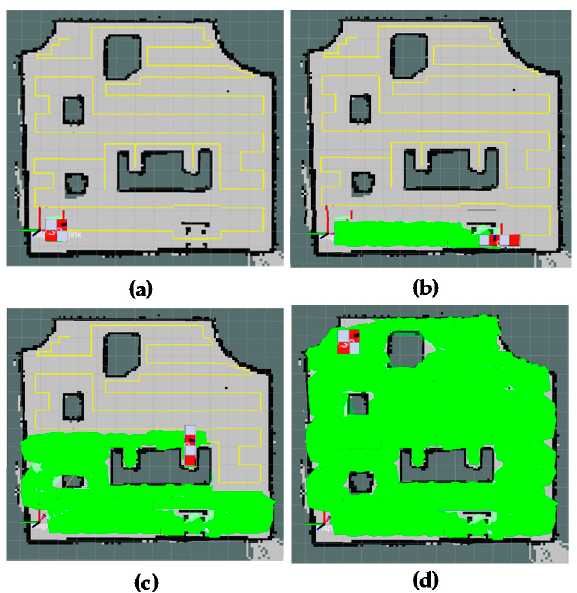
Figure 17. Areas coverage by the proposed method. ( a ) global path planning, ( b ) reconfiguration form O shape to horizontal I shape to cover narrow spaces, ( c ) reconfiguration form O shape to vertical I shape to cover narrow spaces, ( d ) total covered areas. Sensors 2018 , 18 , x FOR PEER REVIEW